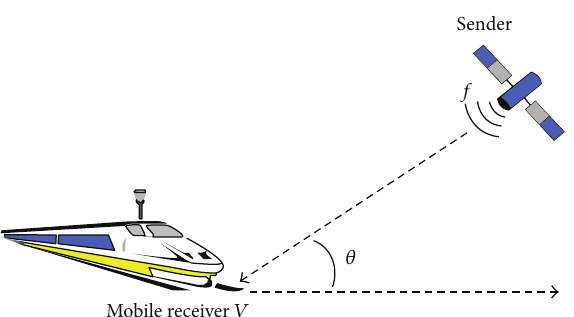
Figure 6: Doppler effect concept for mobile scenario.